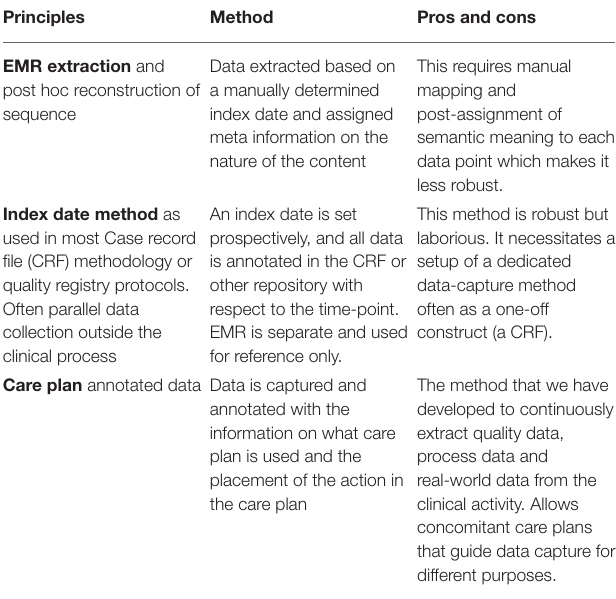
TABLE 2 | The three principal methods of obtaining clinical data in ordered processes for trials, quality control, quality registries and as real-world